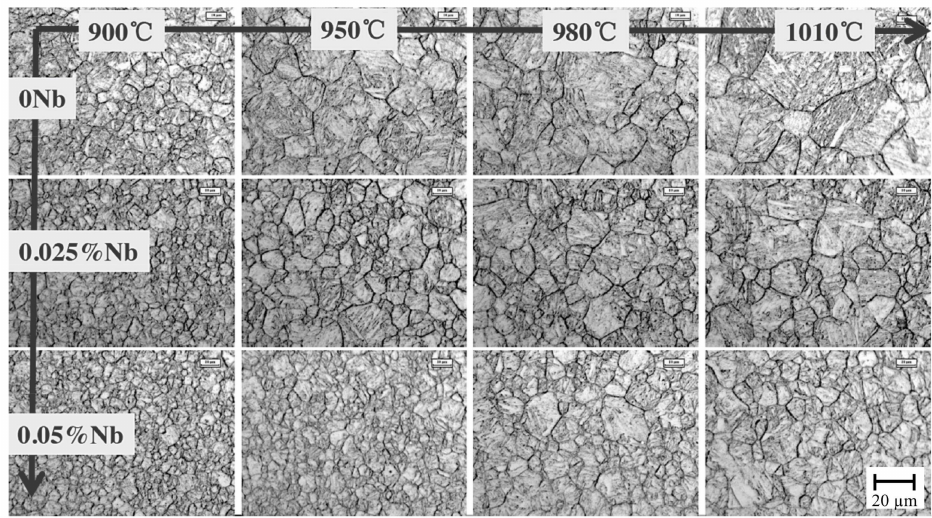
Figure 8. Effect of niobium microalloy content (rows) on parent austenite grain morphology in re-austenitized quenched 22MnB5 steel for various reheating temperatures (columns) for a treatment duration of 300